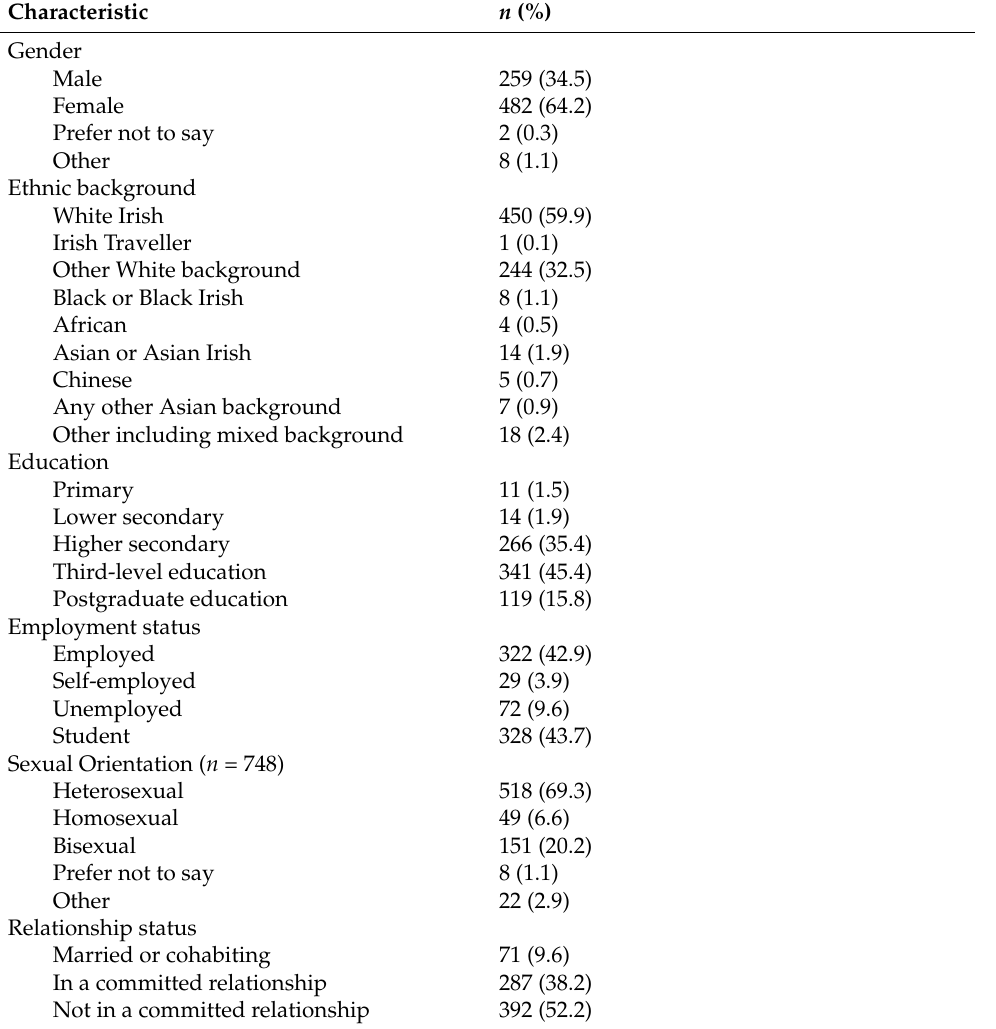
Table 1. Demographic characteristics of participants ( n = 751), including sexual